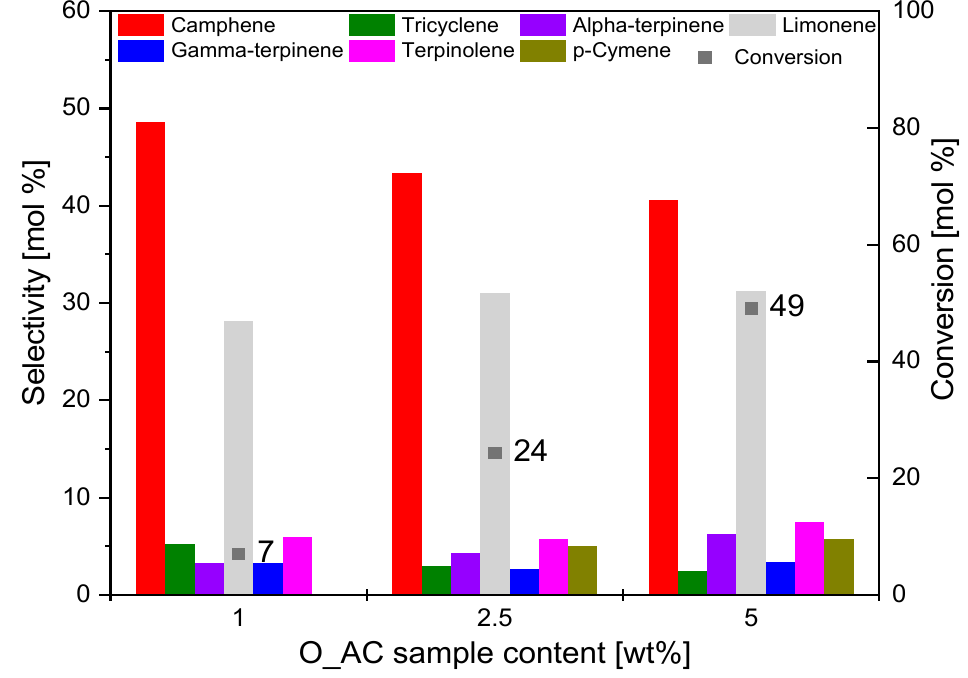
Figure 7. Influence of the O_AC sample content on the selectivity of the main products and conversion of organic raw material (alpha-pinene) after 3 h. of organic raw material (alpha-pinene) after 3